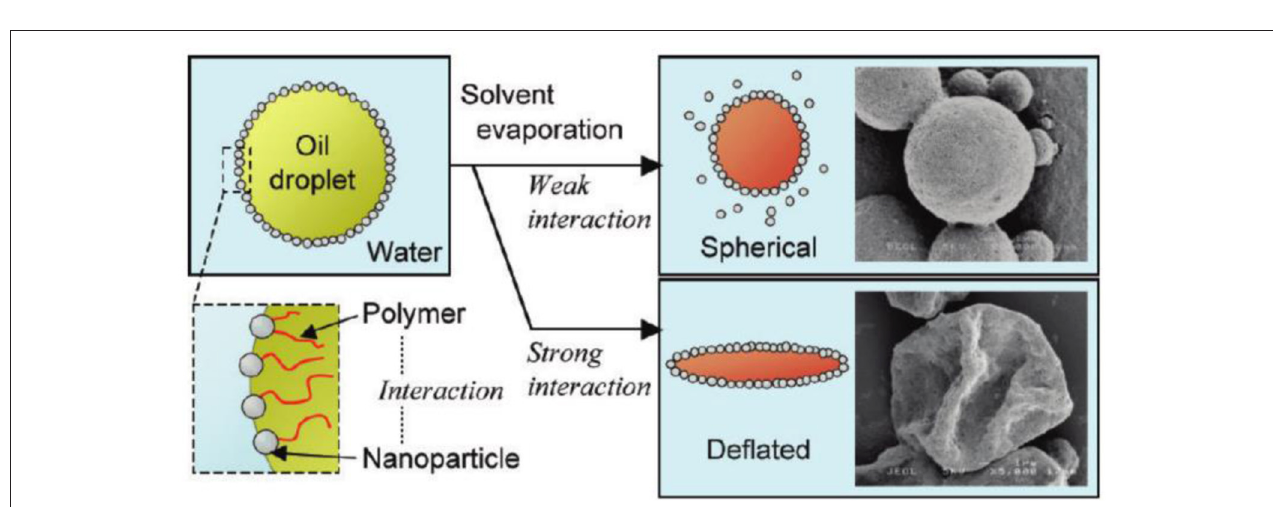
FIGURE 5 | Schematic representation of O/W emulsion stabilized by the combination of hydroxyapatite (HAp) particles in aqueous solution and polystyrene containing end groups in oil phase; and the effect of interaction between HAp particles and polymer on the morphology of microparticles after evaporation of oil phase ( Okada et al., 2012 ). Reprinted with permission from Okada et al. (2012). Copyright 2012 American Chemical